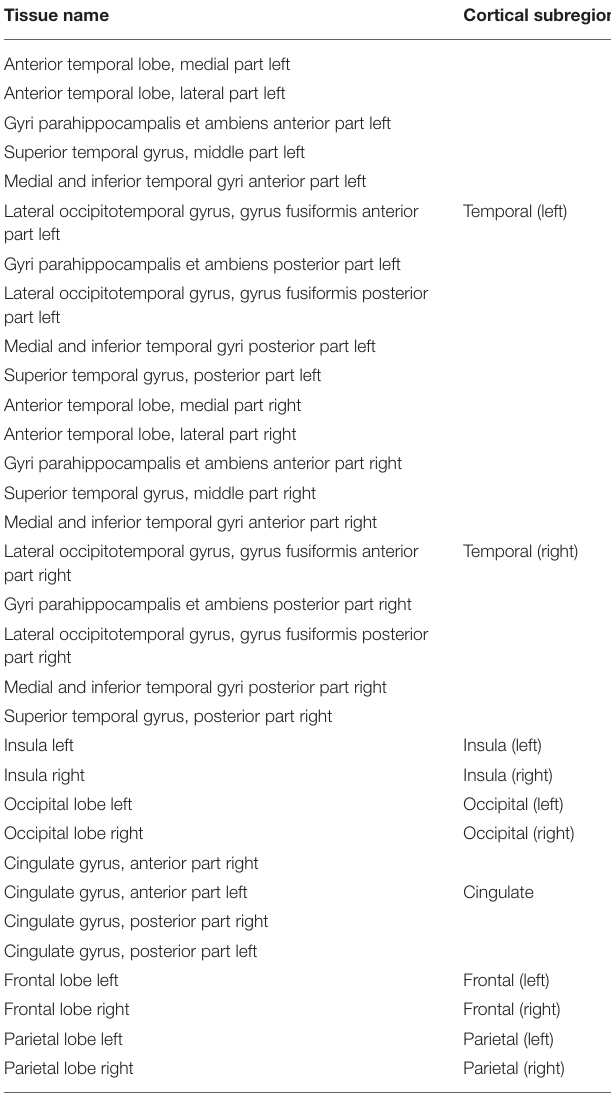
TABLE 2 | Grouping of cortical substructures showing their original tissue name obtained from Draw-EM (Makropoulos et al., 2018) on the first column and their corresponding cortical subregion on the second